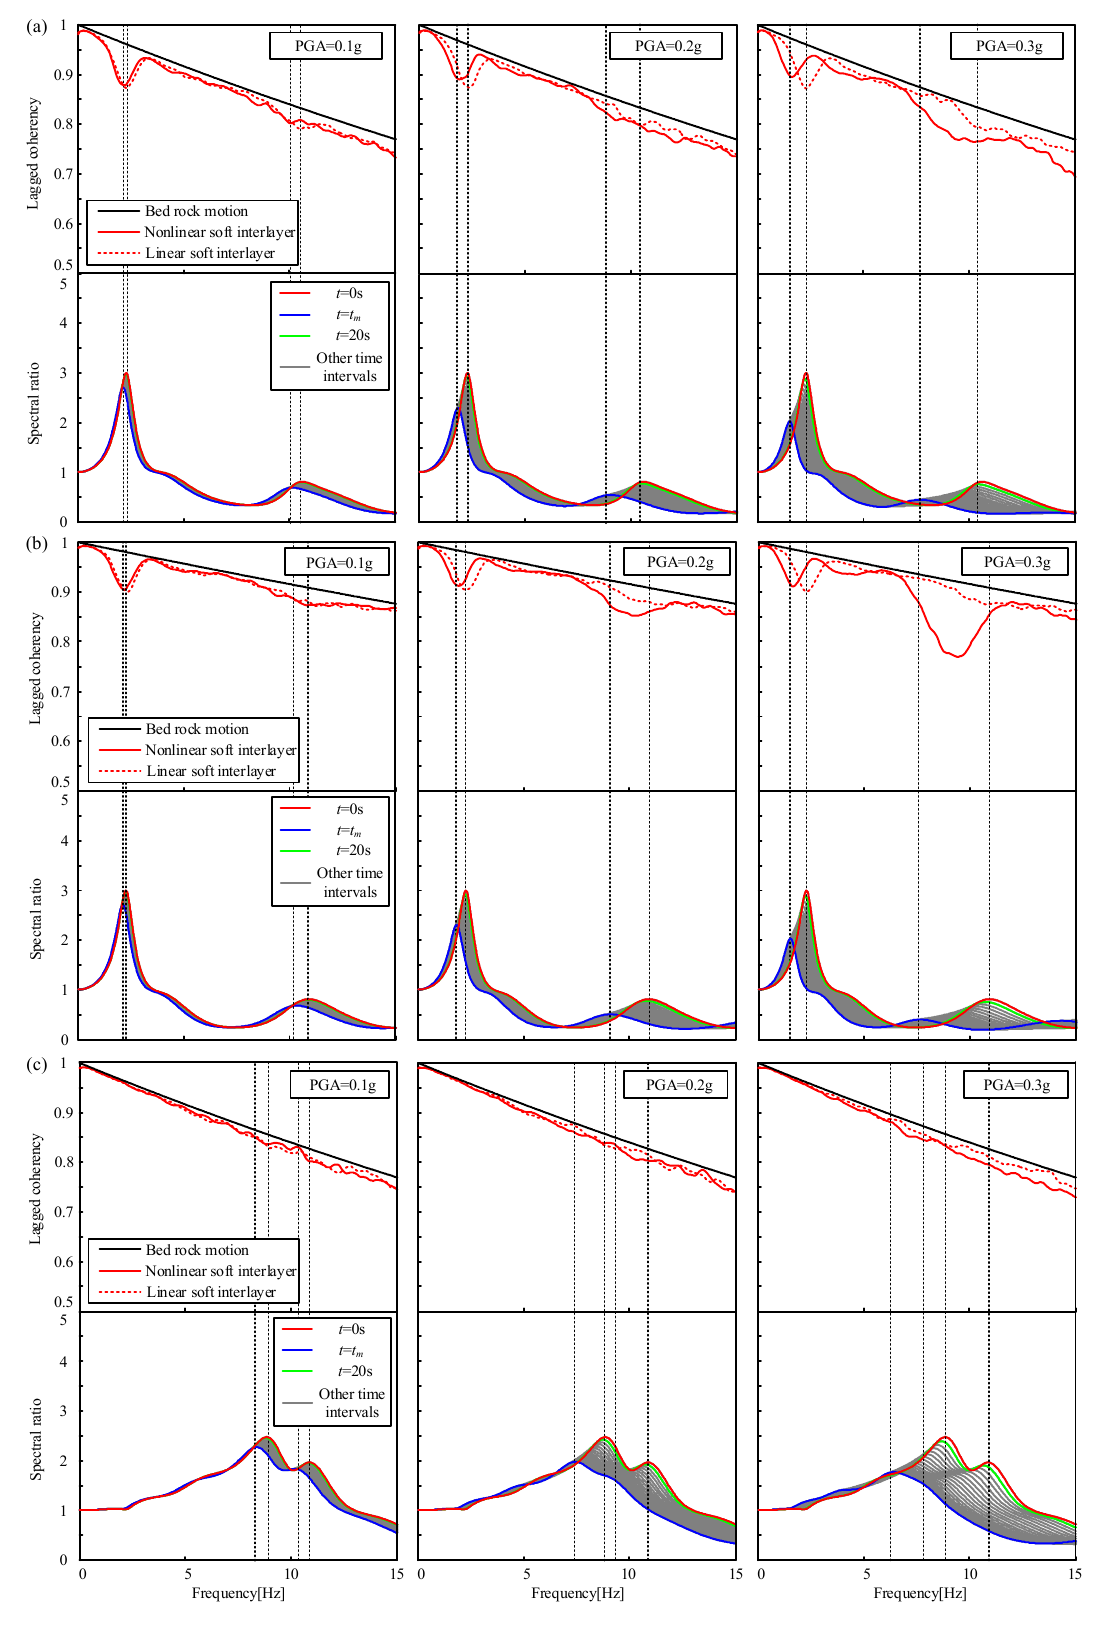
Figure 13. Mean lagged coherency and corresponding time-varying spectral ratios for ( a ) horizontal out-of-plane motions; ( b ) horizontal in-plane motions; and ( c ) vertical in-plane motions under varying PGA of input motion.